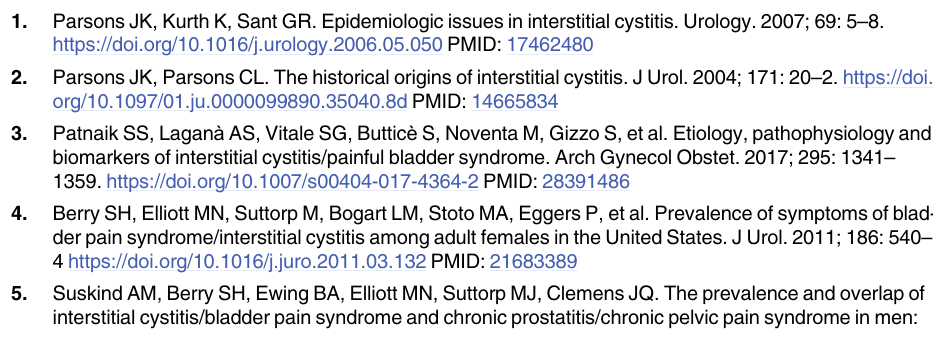
Fig 5. Verification of claudin-2 molecular-targeted MRI (mt-MRI) probe in LPS-exposed URO-MCP-1 mouse bladders. Representative images (i and ii) of streptavidin-horse radish peroxidase (SA-HRP) stained mouse bladders targeting the biotin moiety of the anti-claudin-2 mt-MRI probe in saline (A) or LPS (C)-treated mouse bladders. Note higher levels of claudin-2 probe in LPS-exposed mouse bladders (Ci and Cii). (B) Representative image of a SA-HRP stained mouse bladder targeting the biotin moiety of a non-specific mouse IgG contrast agent in an LPS-exposed mouse bladder. All images are taken at 40x magnification (Bars in each frame are 50 μ m). (D) Quantification of SA-HRP for either the non-specific IgG contrast agent in LPS-treated (n = 5), or the claudin-2 probe in saline- (n = 5) or LPS-treated (n = 5) URO-MCP-1 mouse bladder urothelia. Statistical analysis involved using a two-way ANOVA with multiple comparisons